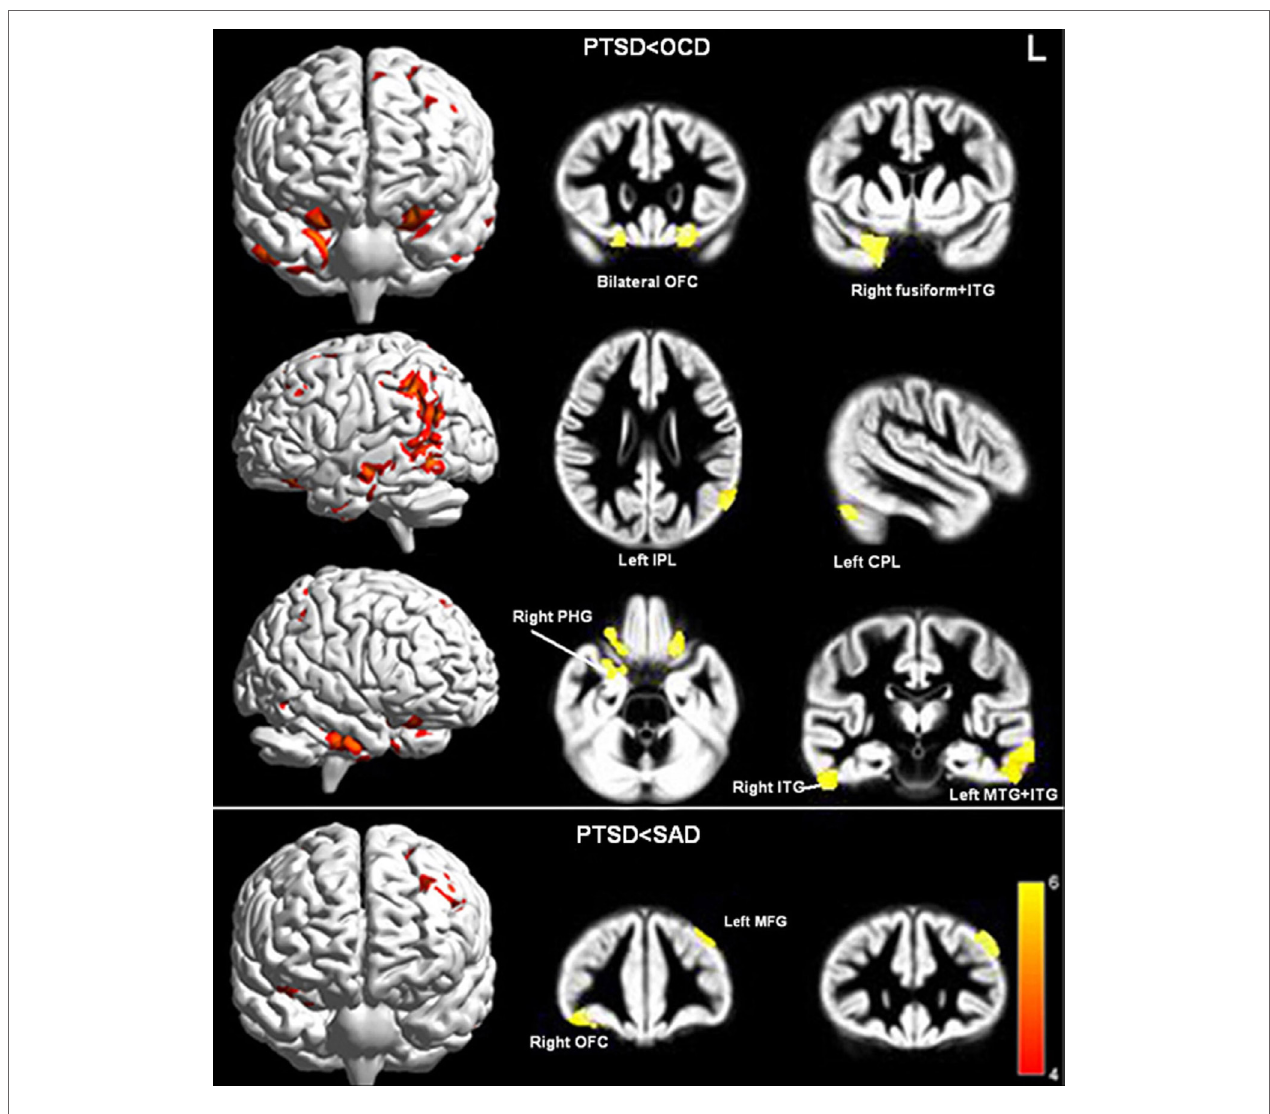
stress disorder; SAD, social anxiety disorder; ITG, inferior temporal gyrus; MTG, middle temporal gyrus; PHG, parahippocampal gyrus; OFC, orbitofrontal cortex; MFG, middle frontal gyrus; CPL, cerebellum posterior